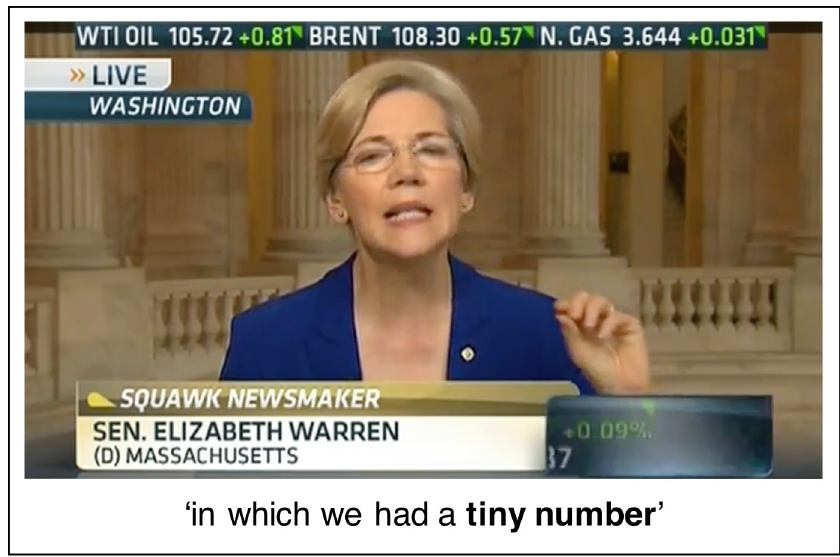
Fig 3. Proportion of videos with the phrases ’tiny number’, ’small number’, ’large number’, and ’huge number’ that occurred without a gesture or with a gesture in a curved, closed, or open hand configuration.